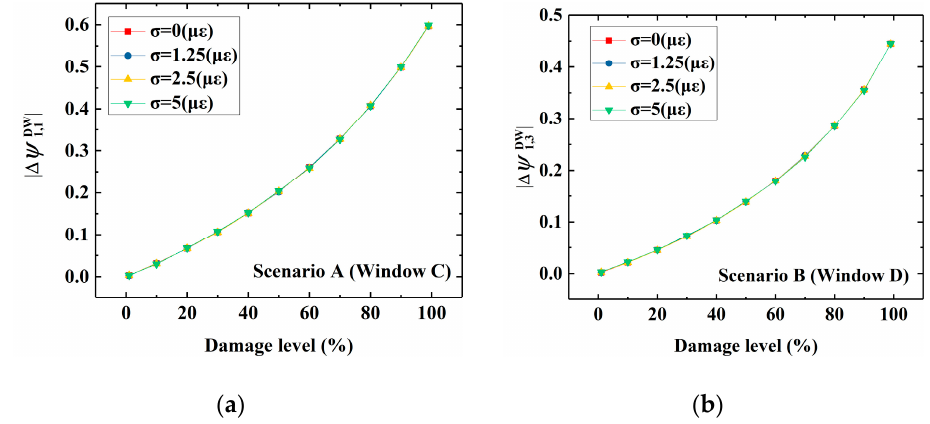
Figure 13. Variation of the absolute value of the CEVs with damage level by DWPCA in the presence of different intensities of noise: ( a ) Scenario A; ( b ) Scenario B.